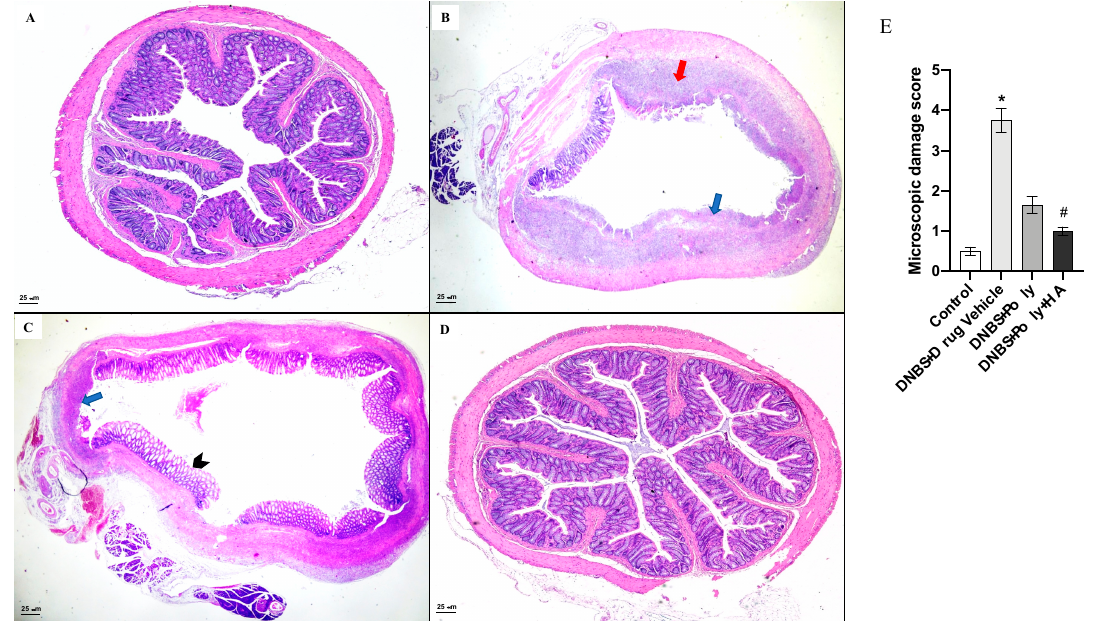
Figure 3. Representative haematoxylin and eosin (H&E) images (original magnification 10×) of tissues derived from control ( A ), DNBS + Drug vehicle ( B ), DNBS + Poly ( C ), DNBS + Poly + HA ( D ). The graph in ( E ) represents the microscopic damage score. Values are expressed as the means and SD of 10 animals. * p < 0.0001 vs. control group; # p < 0.0001 vs. DNBS + Drug vehicle group. The blue arrow indicates mucosal ulceration; the red arrow indicates granulation tissue; the arrow head indicates pseudopolyps.